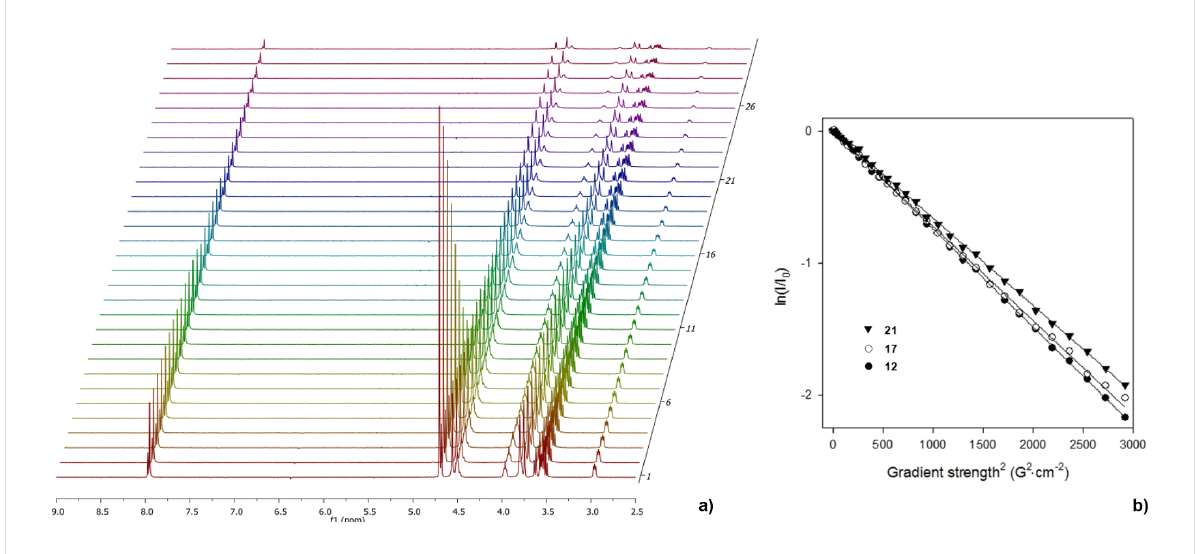
Figure 1: a) Decay of 1 H signal for the nonavalent mannosylated compound 12 in D 2 O during the PFGSTE experiment. The gradient strength is increased linearly between 1.8 and 54.2 G·cm − 1 ; b) characteristic echo decays of the H-5 resonances ( δ = 2.98 ppm) as a function of squared gradient strength located in 12 (full circles) and 21 (full triangles) with δ = 4 ms and Δ = 50 ms ( Δ = 40 ms for 17 (circles)). Notably, such linear behavior was also obtained for the decay of the signal intensities of other protons located either in internal regions of the conjugates on aromatic or branching sections, or in the peripheral saccharidic belt (results not